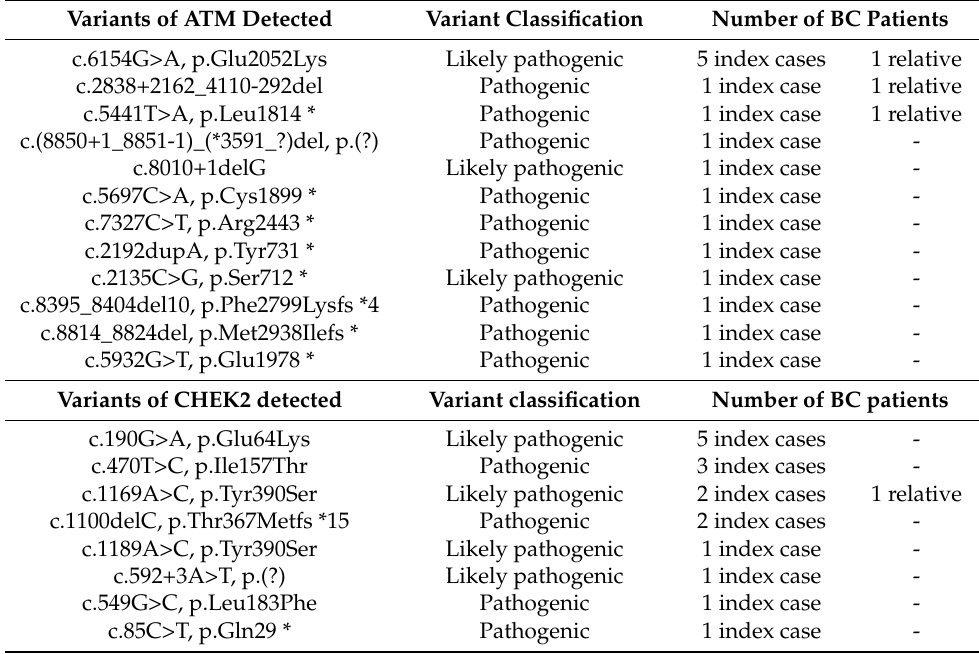
Table 2. Likely pathogenic and pathogenic variants of ATM and CHEK2 in our study population of BC patients.